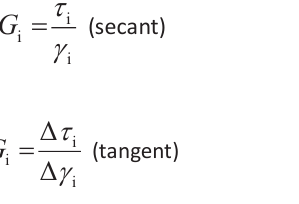
Fig. 10. Results of TS analysis – sample S3057.